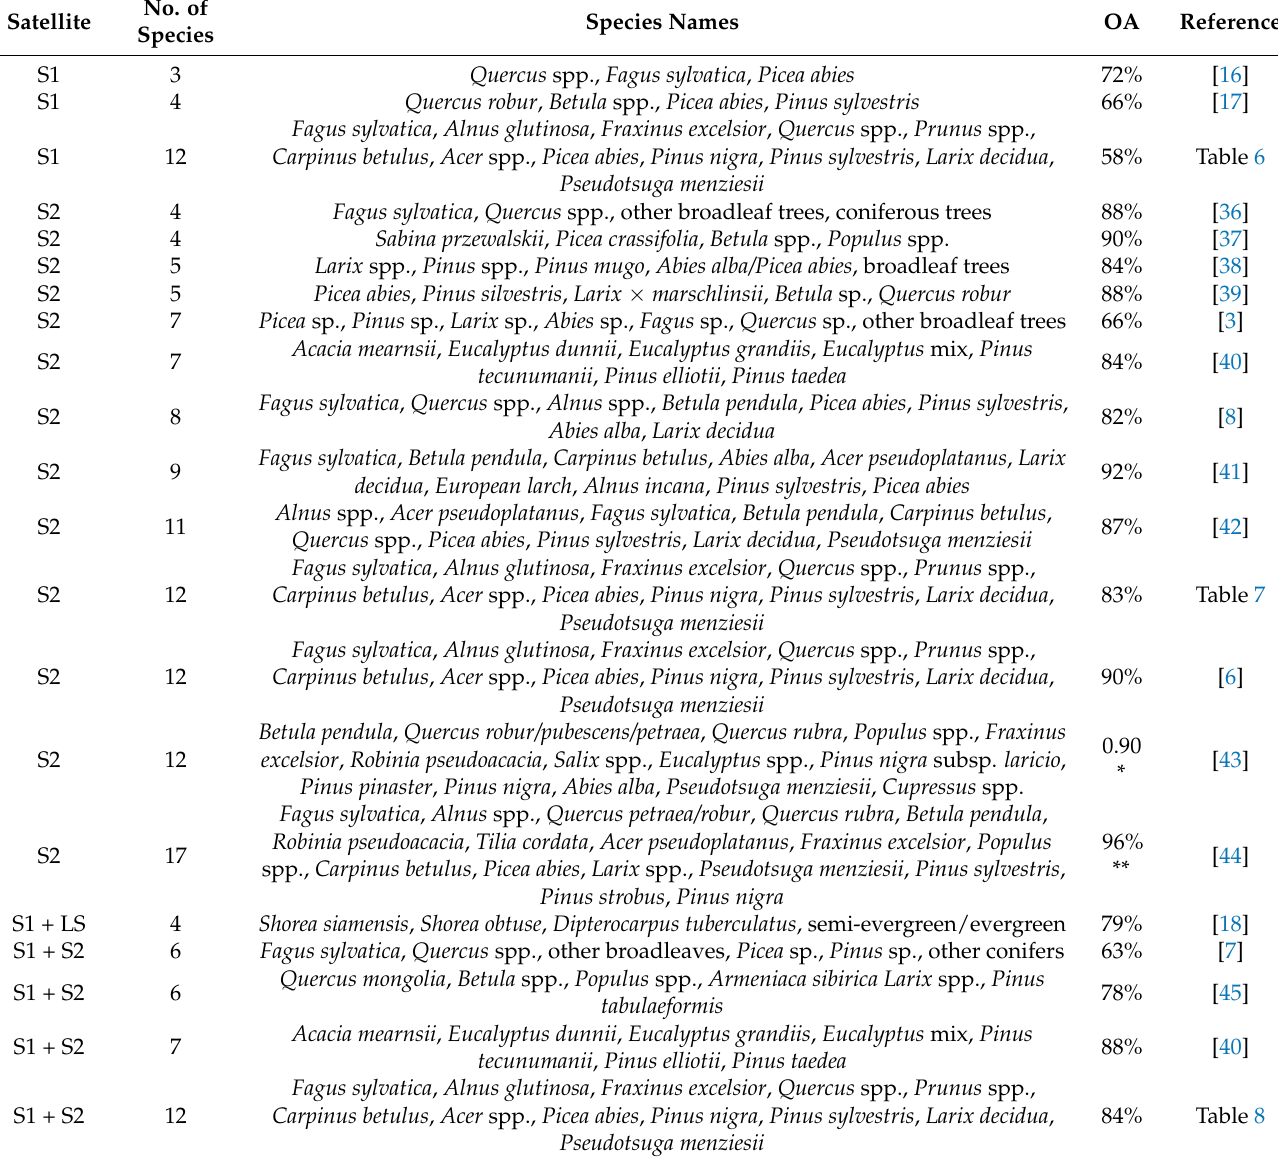
Table 9. Summary of previous studies using Sentinel-1 (S1), Sentinel-2 (S2), and both combined for tree species classification and their achieved overall accuracies